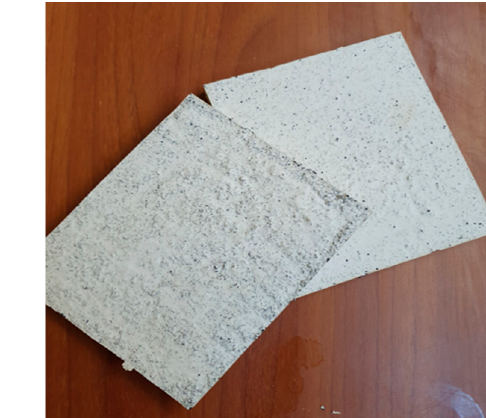
Figure 6. Schema of the sample test bench for sound absorption.